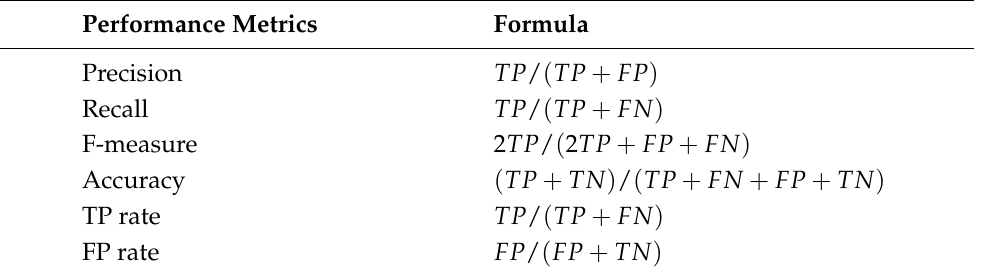
Table 3. The used performance